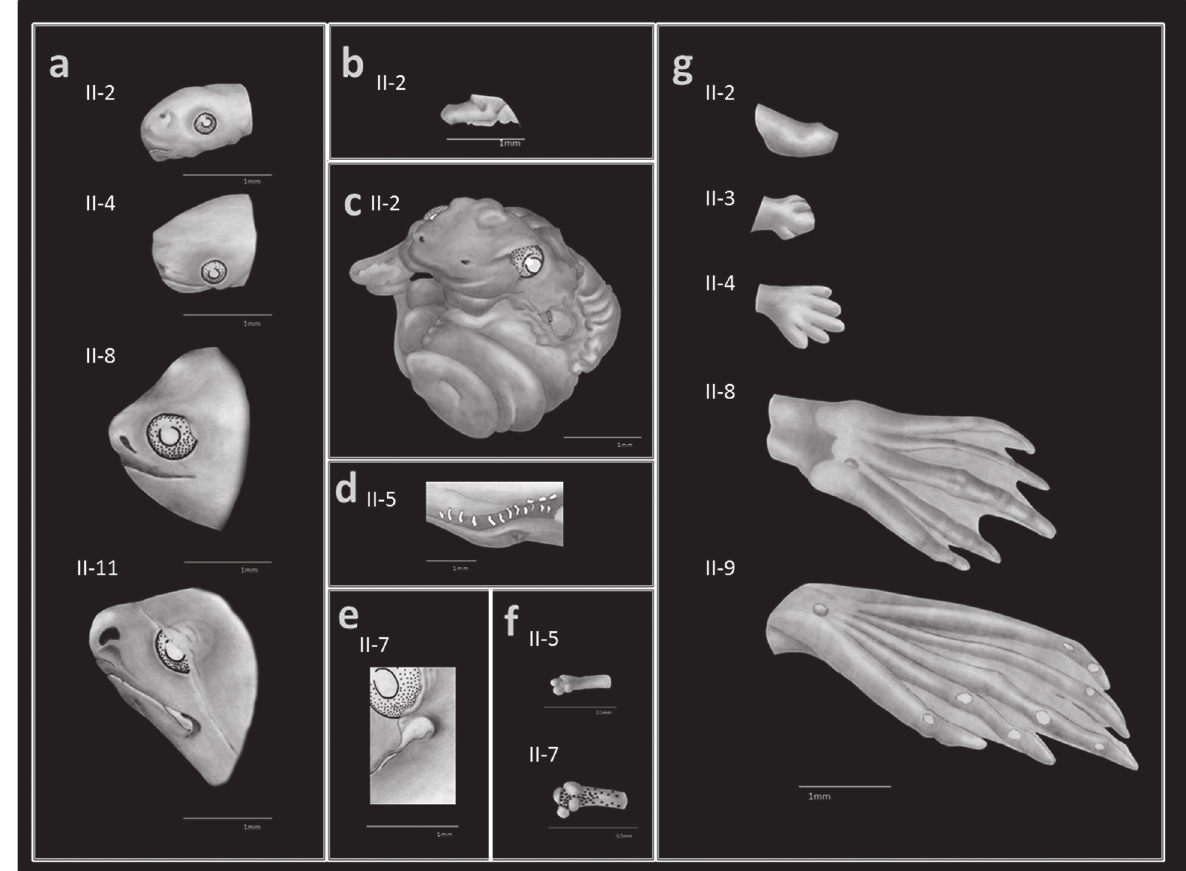
Figure 2 - Camera lucida drawing of Pipa arrabali embryos. a - Left lateral view of the head of Stage II-2 (CHUnB 35027-D), II-4 (CHUnB 35000-D), II-8 (CHUnB 35056-D), and II-11 (CHUnB 35053-D) showing the differences in the position of the angle of the mouth relative to nostrils and eyes; in II-11 also showing the dermal fold covering partially the eye. b - Lateral view of left forelimb, inside gill chamber, of Stage II-2 (CHUnB 35027-D), showing the elbow joint (in the drawing was omitted the cover skin of the gill chamber, focusing only on the forelimb). c - Fronto-ventral view of Stage: II-2 (CHUnB 35027-D) showing the coiled intestine full of yolk. d - Left lateral view of the trunk, in between arm and leg, of Stage II-5 (CHUnB 35045-D) showing the pores of the upper and middle lateral lines. e - Left lateral view of the mouth of Stage II-7 (CHUnB 35030-D) showing the dermal modification of the upper lip. f - Latero-frontal view of the fingertip morphology of Stages II-5 (CHUnB 35045-D) and II-7 (CHUnB 35030-D). g - ventral view of the right hind limb of Stages II-2 (CHUnB 35027-D), II-3 (CHUnB 35055-D), II-4(CHUnB 35000-D), II-8 (CHUnB 35056-D), and II-9 (CHUnB 35051-D) showing feet development and